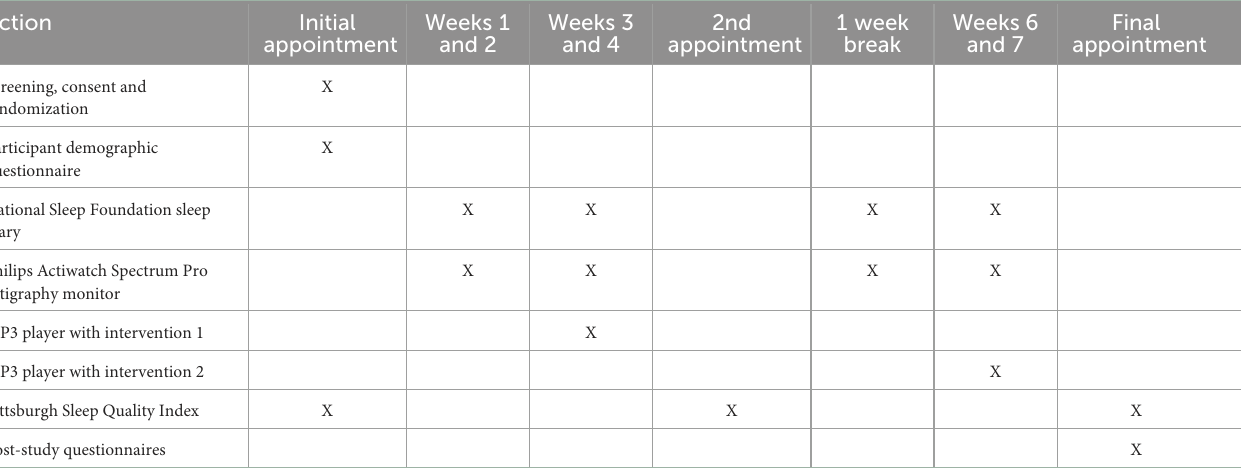
TABLE 2 Data collection